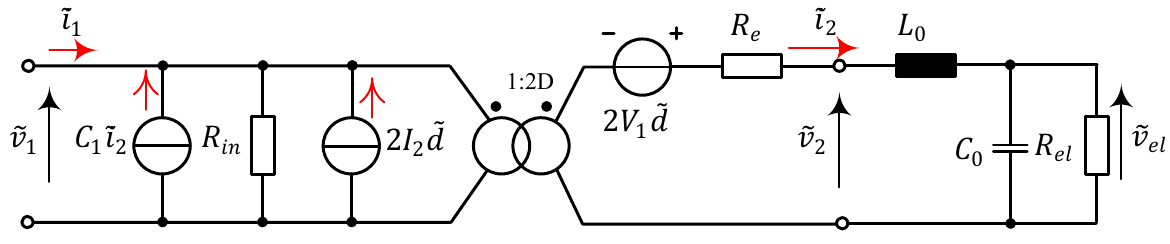
Figure 4. signal model of the proposed converter.